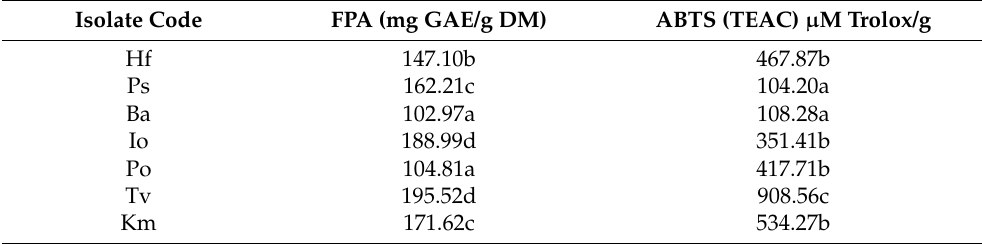
Table 3. The flavonoids concentration of 7 fungal isolates ( mg/kg DM in mycelium ).